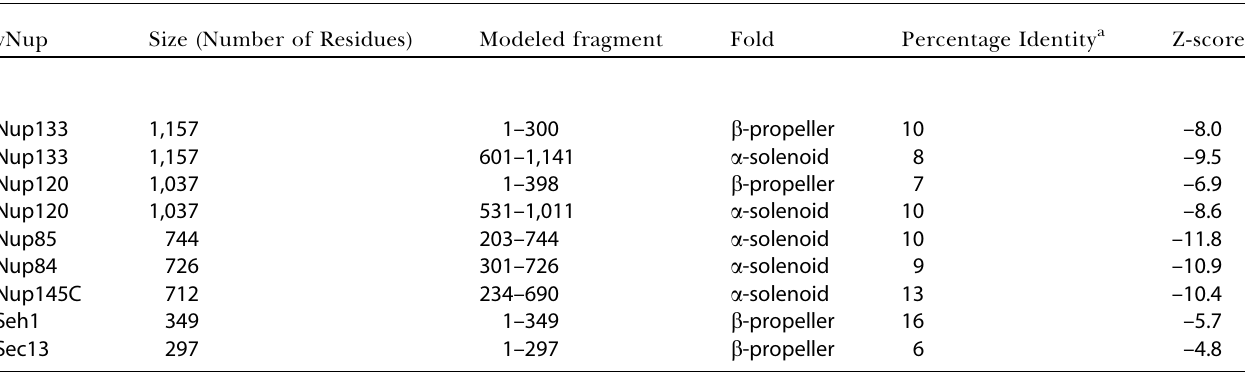
Table 1. Nup84 Subcomplex Proteins are Composed of Two Fold Types